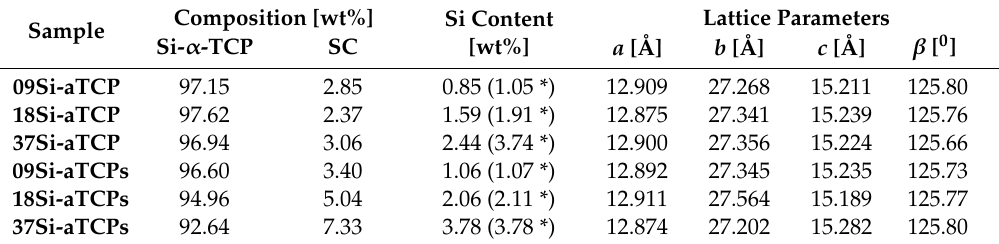
Table 1. Chemical compositions of the obtained powders (quantitative phase analysis, Si wt% contents) and lattice parameters from PXRD